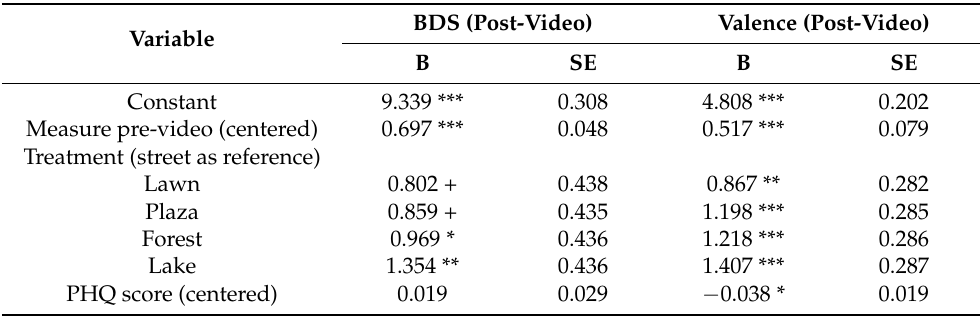
Table 3. Results of regression models testing depressive symptoms (PHQ-9 sum score) on BDS score and